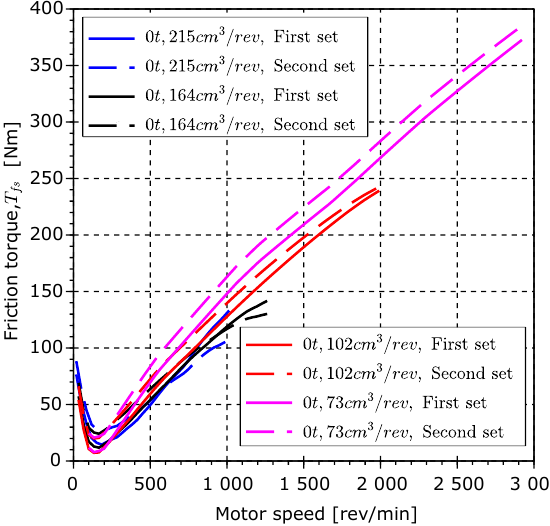
Figure 14: Calculated system friction for tests with 0 t hook load (hook weighs approx